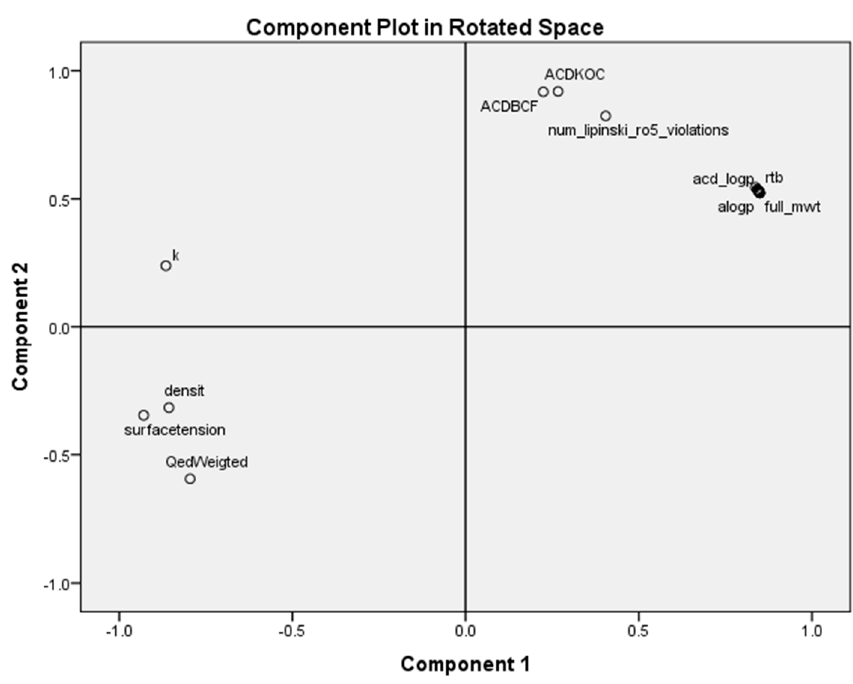
Figure 5. Loading plot of variables for homologous series of chloromethyl ketones with acetyl at R 1 . On the one hand, PC 1 (87.6% of the total variance) shows positive loading mainly with acd_logp, rtb, full_mwt, alogp, num_lipinski_ro5_violations, ACD/KOC and ACD/BDF, as well as negative loading with surface_tension, QedWeigted, density and stability k . On the other hand, principal PC 2 (8.3% of the total variance) shows positive loading, mainly with ACD/BDF, ACD/KOC, num_lipinski_ro5_violations and k . The rest of the variables are near the origin and are less important for PC 2 .